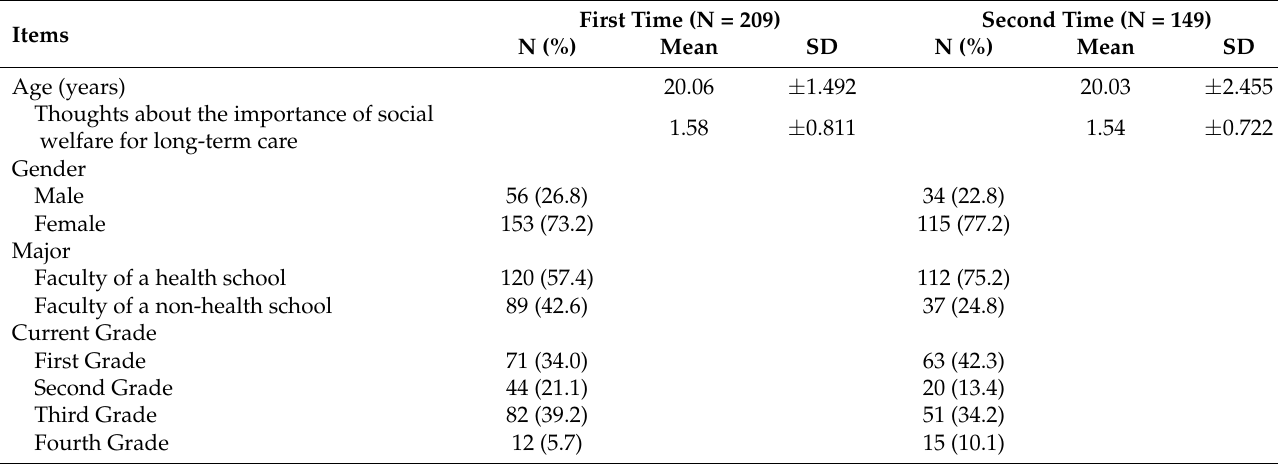
Table 1. Personal attributes of the